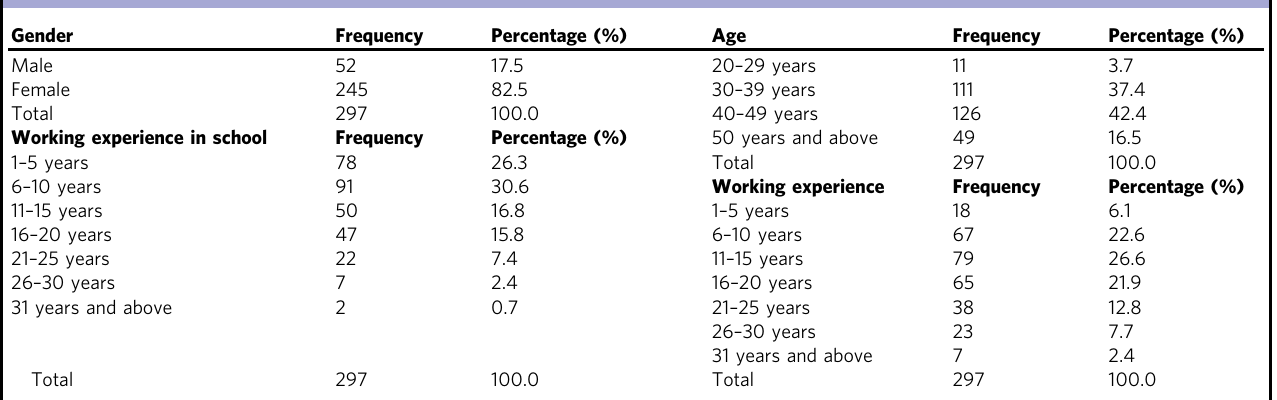
Table 5 Demographic information on the research participants.